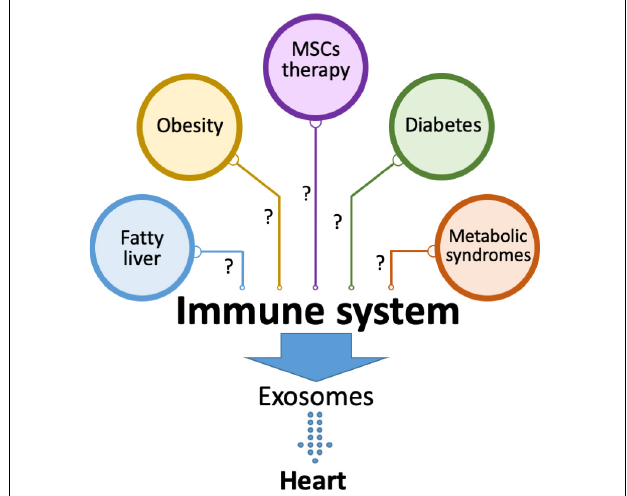
FIGURE 2 | Exosomes from the immune system affect cardiac tissue. Immune system is modulated under different metabolic settings including diabetes, obesity, fatty liver and metabolic syndromes. The role of exosomes secreted by immune cells under these conditions in heart pathology is yet to be fully described. It is also not known whether the beneficial effects of stem cell-based therapies in heart diseases are mediated by immune modulation that may lead to the release of cardio protective